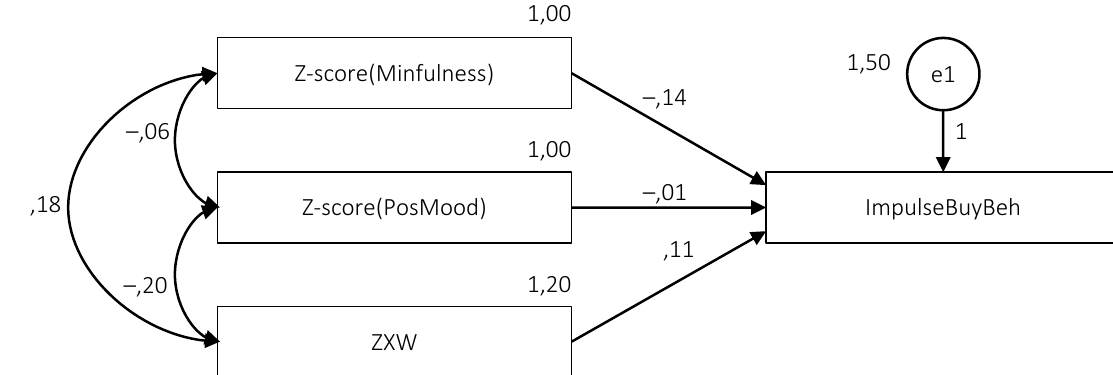
Figure 5. The standardized path diagram of the moderator effect of positive mood on the relationship